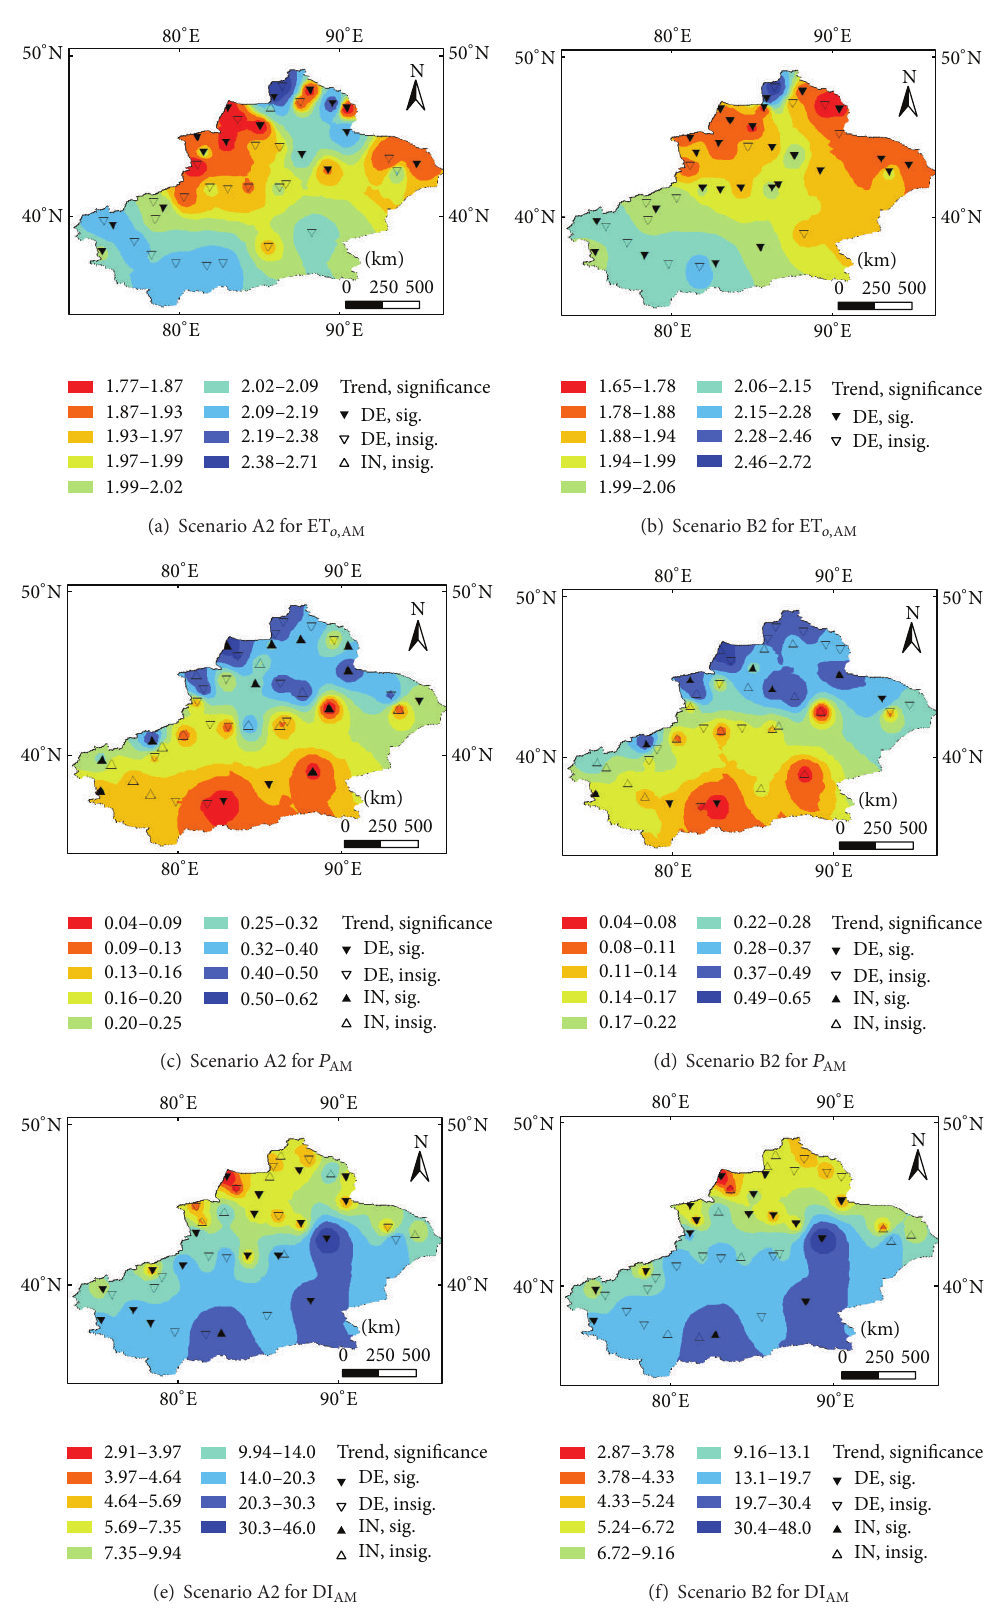
Figure 4: Spatial distributions and the trend test results for 𝑃